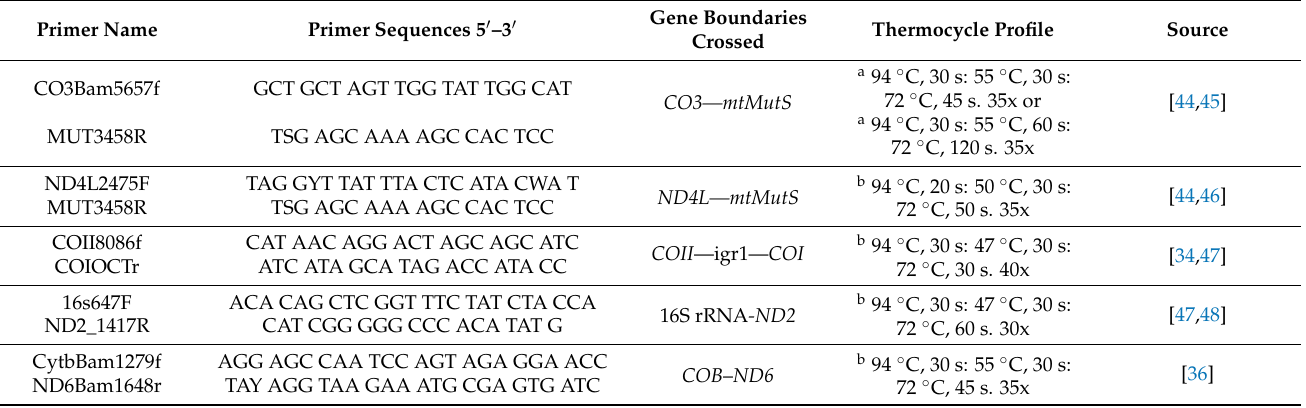
Table 1. Primer thermocycle profiles used to amplify mitochondrial gene fragment